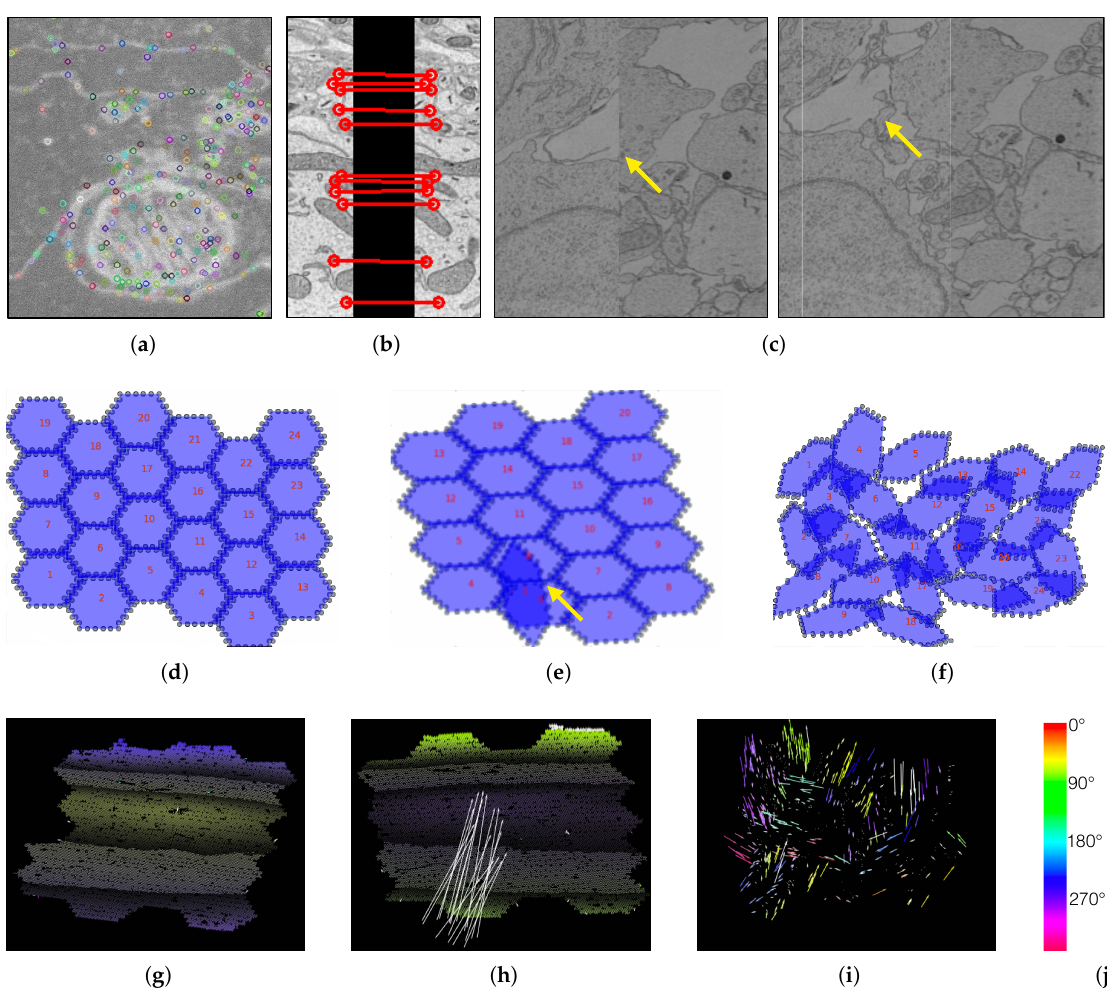
Figure 4. We create visualizations to monitor and debug the registration process. ( a ) We visualize scale-invariant feature transform (SIFT) features within an image tile. ( b ) We visualize these features when looking at overlapping tiles. ( c ) We render aligned MFOVs before and after the registration. ( d ) A correct transformation can be seen where the MFOVs appear to be slightly rotated clockwise. ( e ) Here we see an erroneous transformation for one MFOV. Further examination reveals that the mismatched MFOV (yellow arrow) is incorrectly matched with the features of the neighboring section. ( f ) This visualization shows a case where most MFOVs are incorrectly transformed. This is caused by a large rotation of the neighboring section, which has severe impact on the accuracy of SIFT features. The vector fields in the bottom row show the displacement of each single match between adjacent sections (after an affine alignment to align these two sections). We color code by angle. ( g ) A “normal” matching. The sections are more or less on top of each other, but after the affine alignment the top and bottom parts (purple) are stretched to the bottom left, and the middle (yellow) is stretched towards the top right. Some white arrows are outliers. ( h ) A case where one MFOV was not pre-aligned properly, and so all its arrows are white. ( i ) A case where the pre-alignment gave bad results. ( j ) The color map for visualizing the displacement